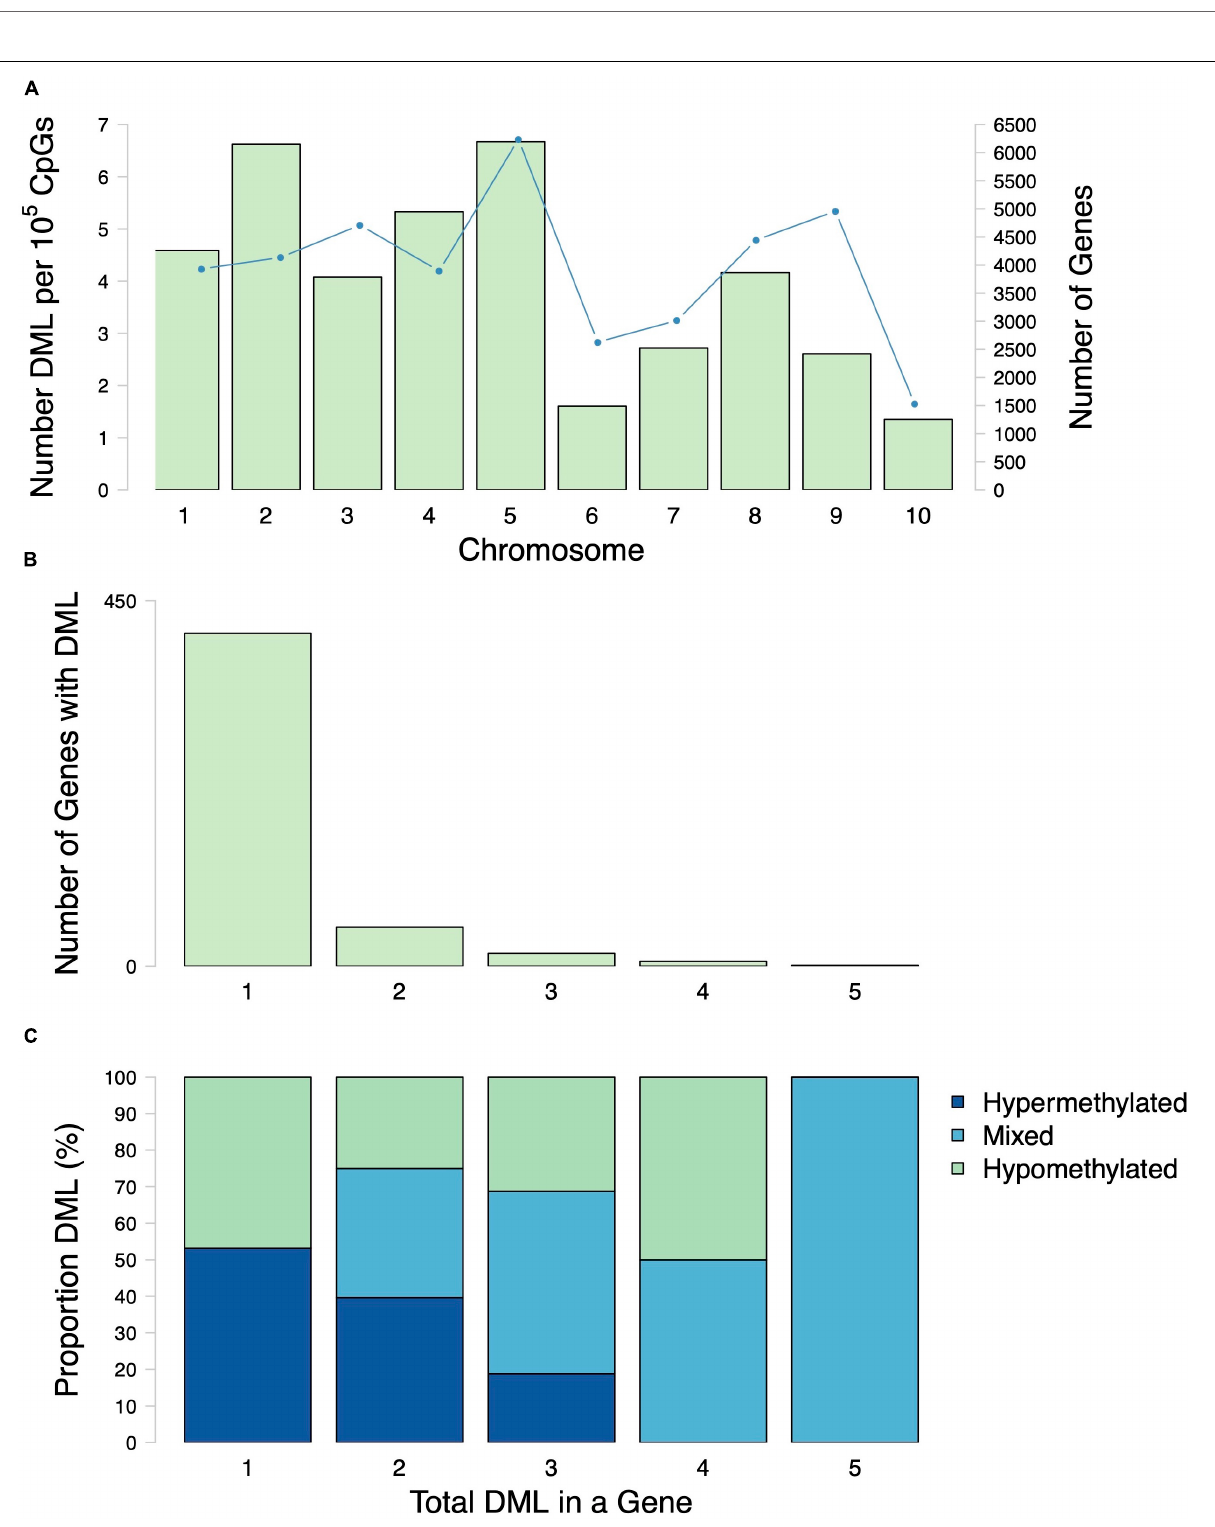
Frontiers in Marine Science |